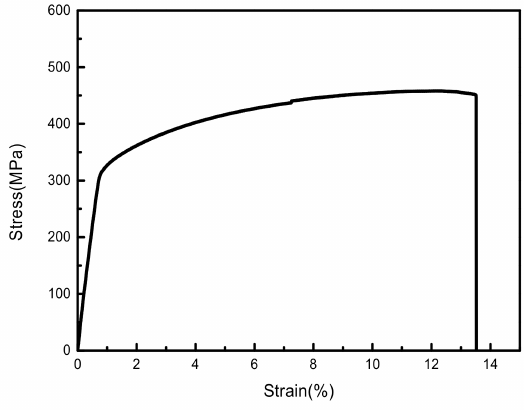
Figure 1. Standard creep aging sample (unit: mm).